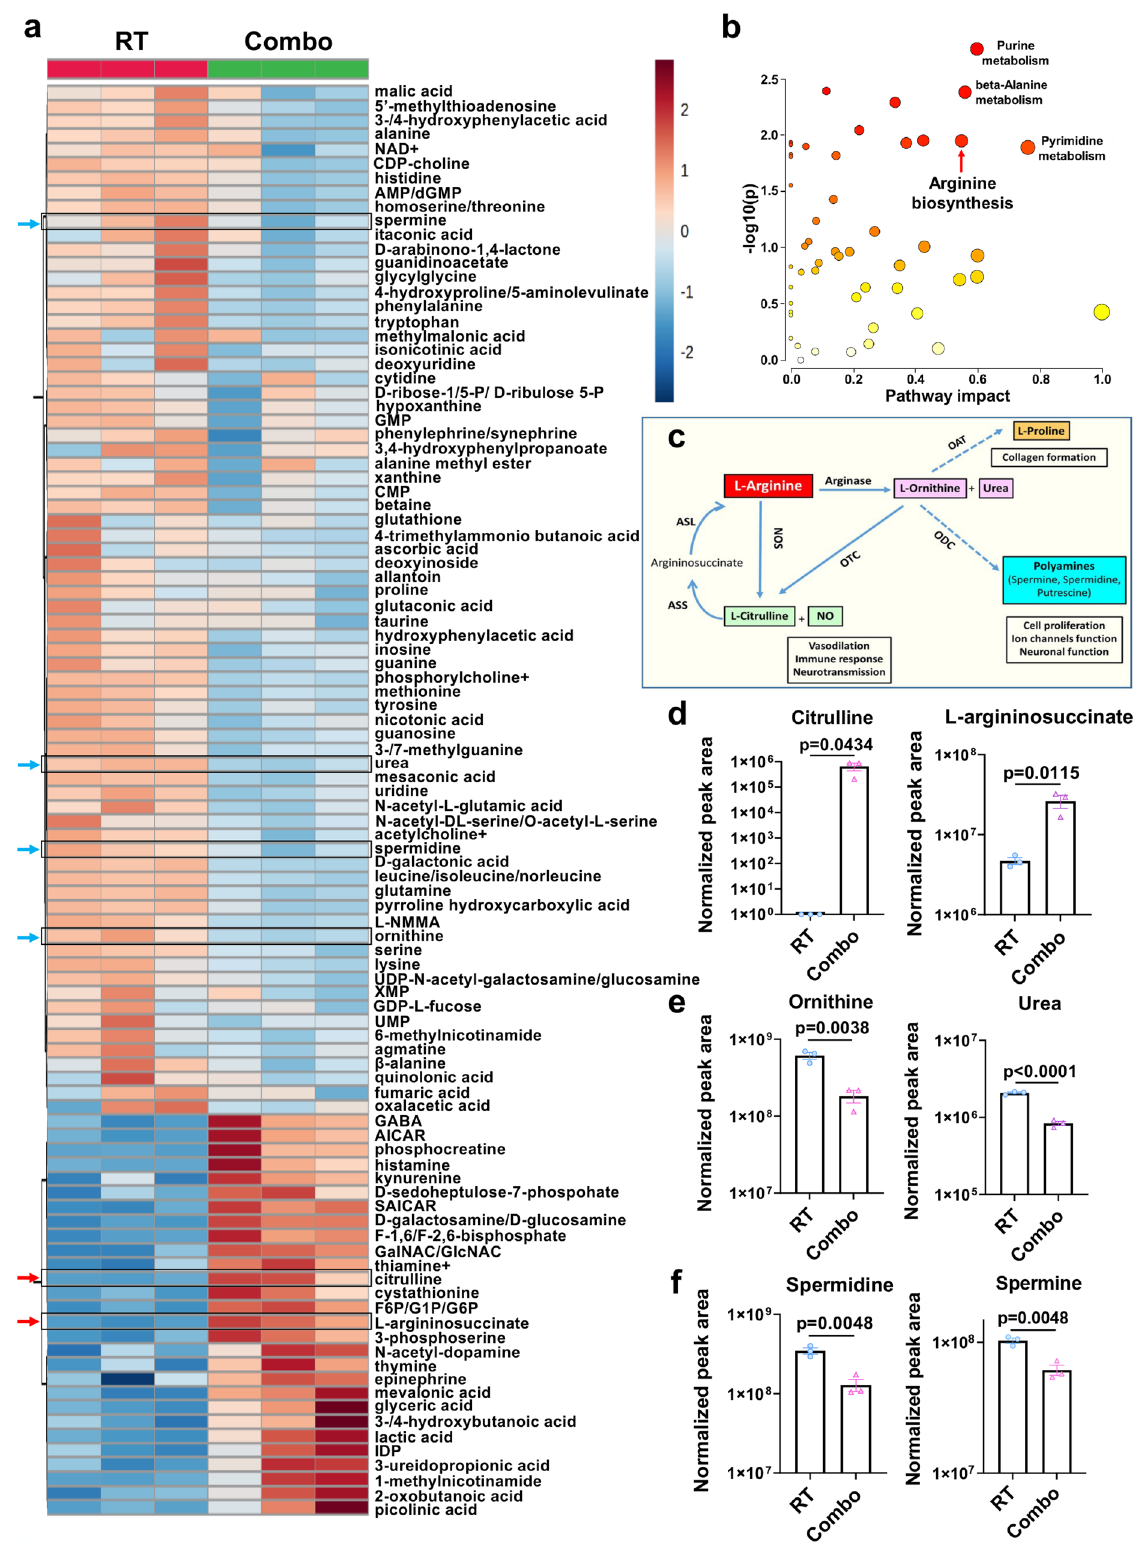
Fig. 4 | B-LNP/diABZI treatment reprograms metabolic features of TAMC. Bulk metabolomic analysis of TAMCs from CT-2A-bearing brains of C57 mice received radiotherapy (RT) or RT+B-LNP/diABZI combination therapy (referred to as Combo).Unbiasedmetabolomics( a )andmetabolicpathwayanalysis( b )ofTAMCs from brain tumors. c Schematic illustration ofthe arginine metabolic pathway. LC-